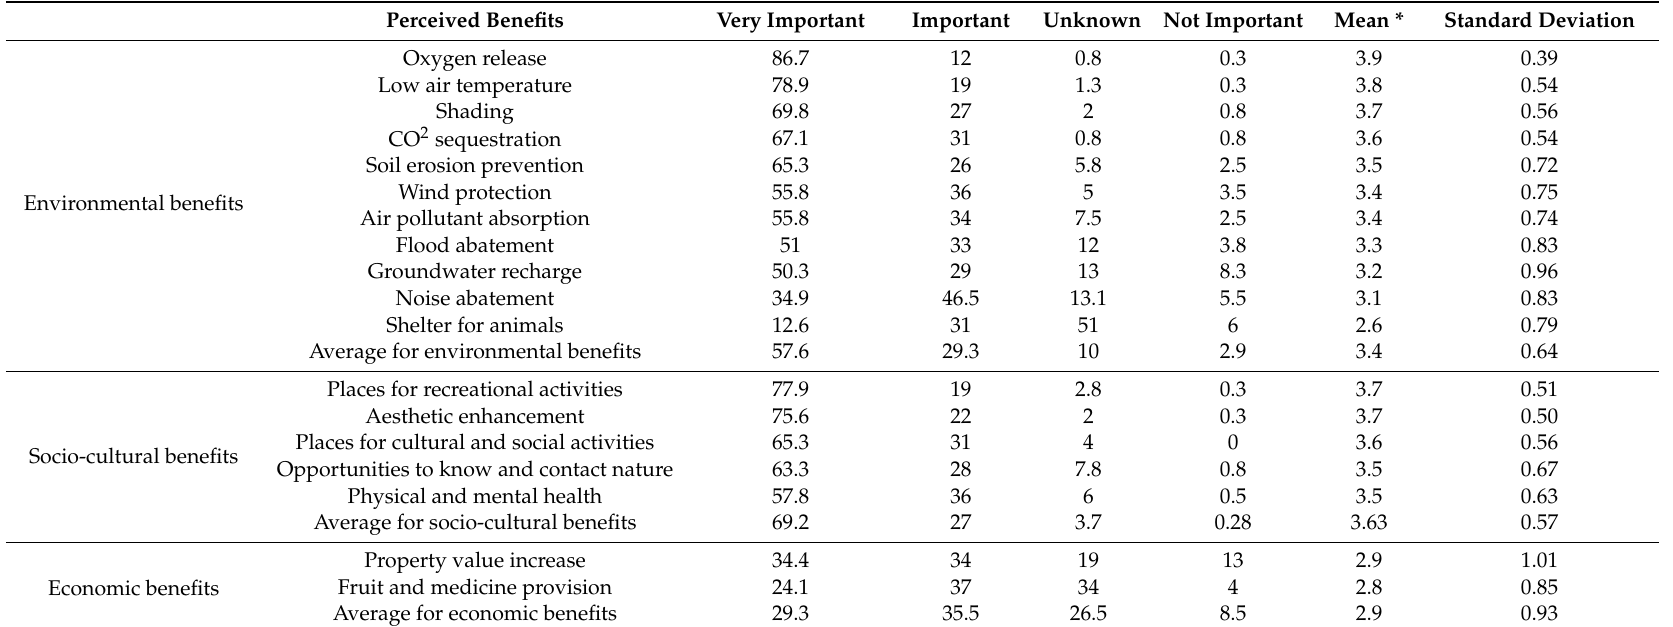
Table 3. Percentage value of residents’ perception of the benefits of neighborhood